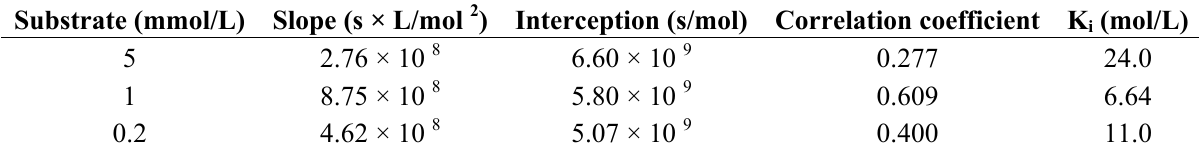
Table 2. Search on inhibitory mechanism using human